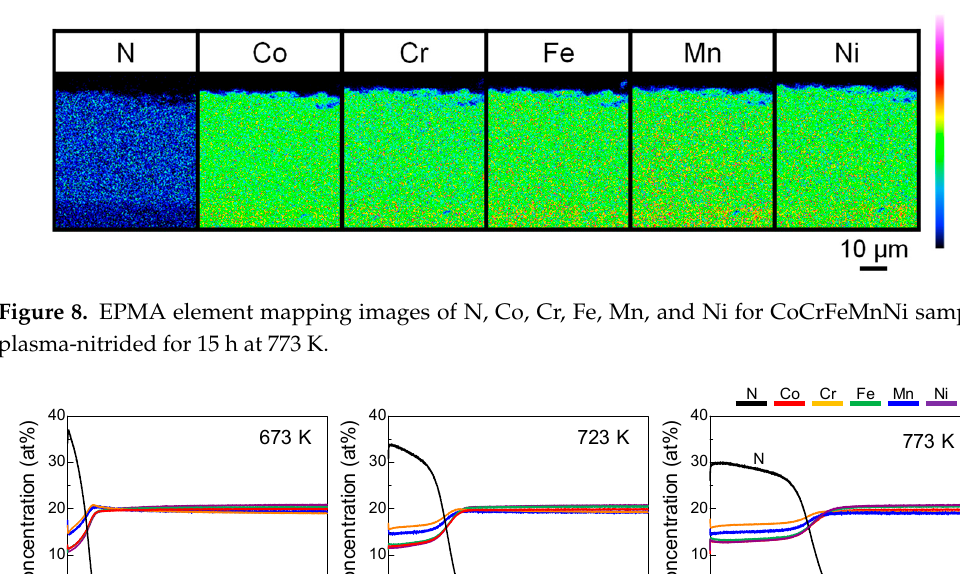
Figure 7. Surface morphology of plasma-nitrided CoCrFeMnNi samples.